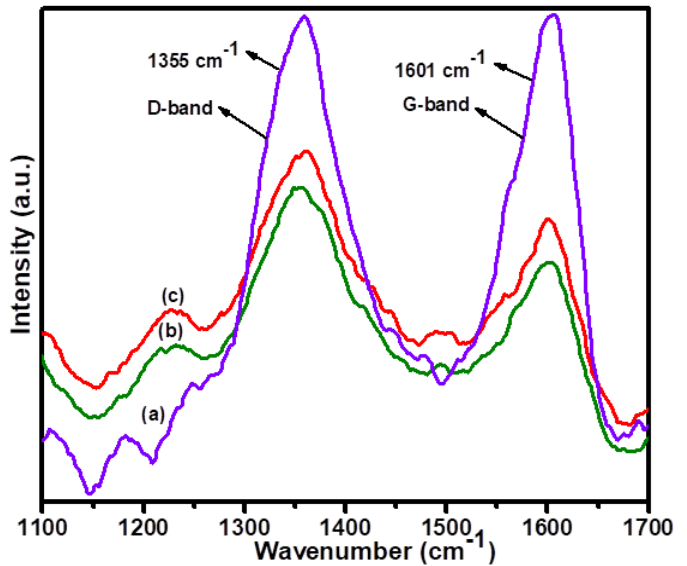
Nanomaterials 2021 , 11 , x FOR PEER REVIEW Figure 2. Raman spectra of ( a ) 1Cu(0)-AAPTMS@RGO-MCM-41, ( b ) 5Cu(0)-AAPTMS@RGO-MCM-41, and ( c ) 10Cu(0)-AAPTMS@RGO-MCM-41 samples..